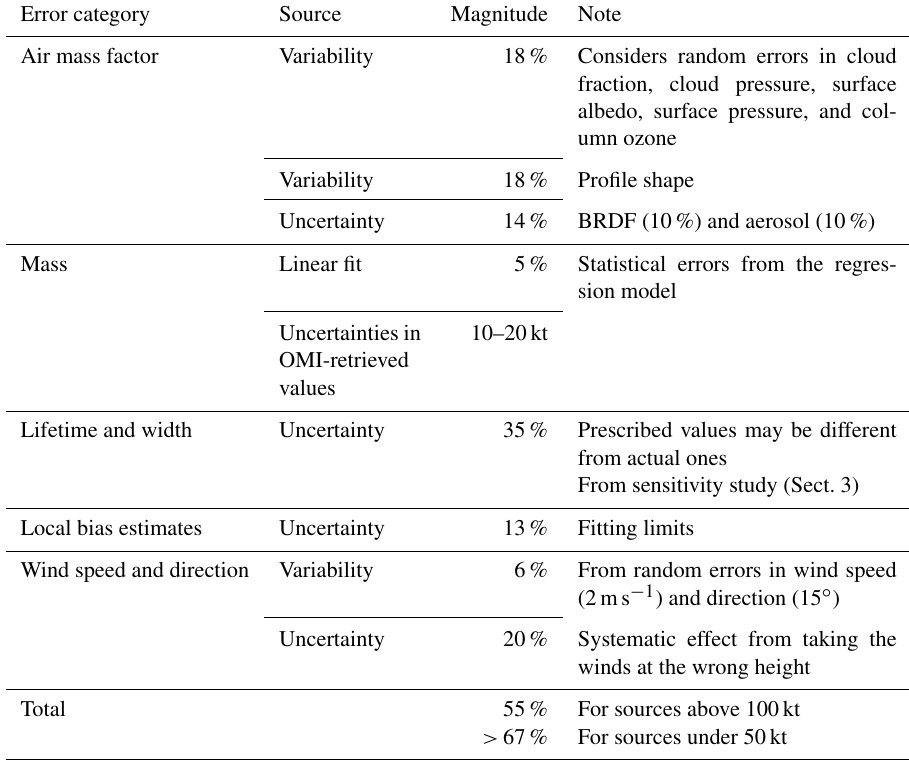
Table 1. Uncertainty budget for annual emission